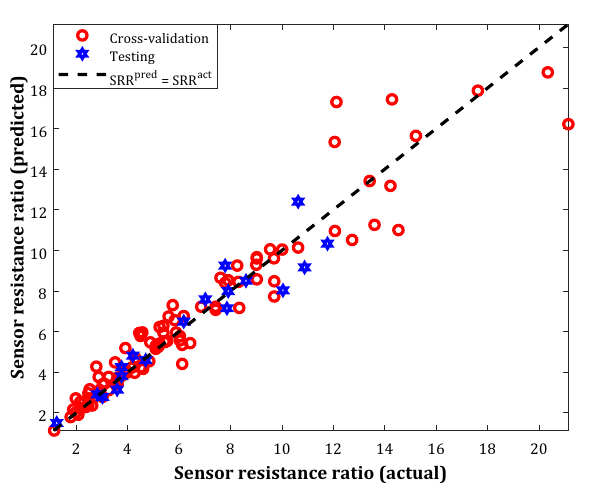
Figure 8. Correlation between predicted SRRs by the optimum WT-ANN and their related actual